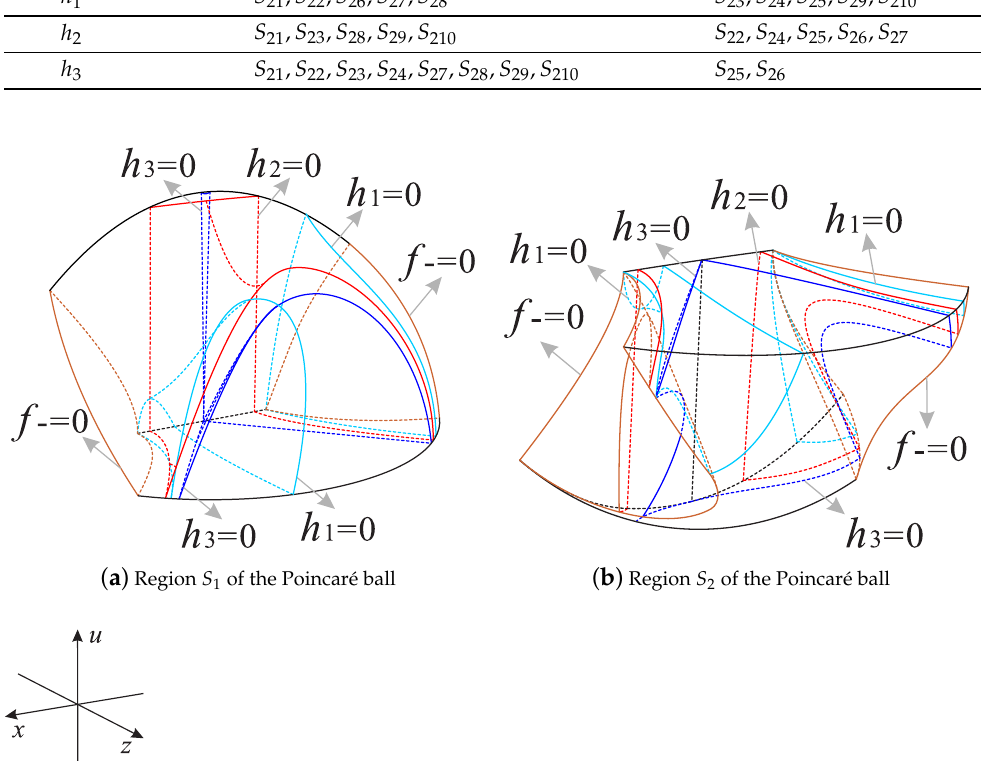
Table 8. Signs of functions h 1 , h 2 and h 3 in the subregions of S 2 . Functions